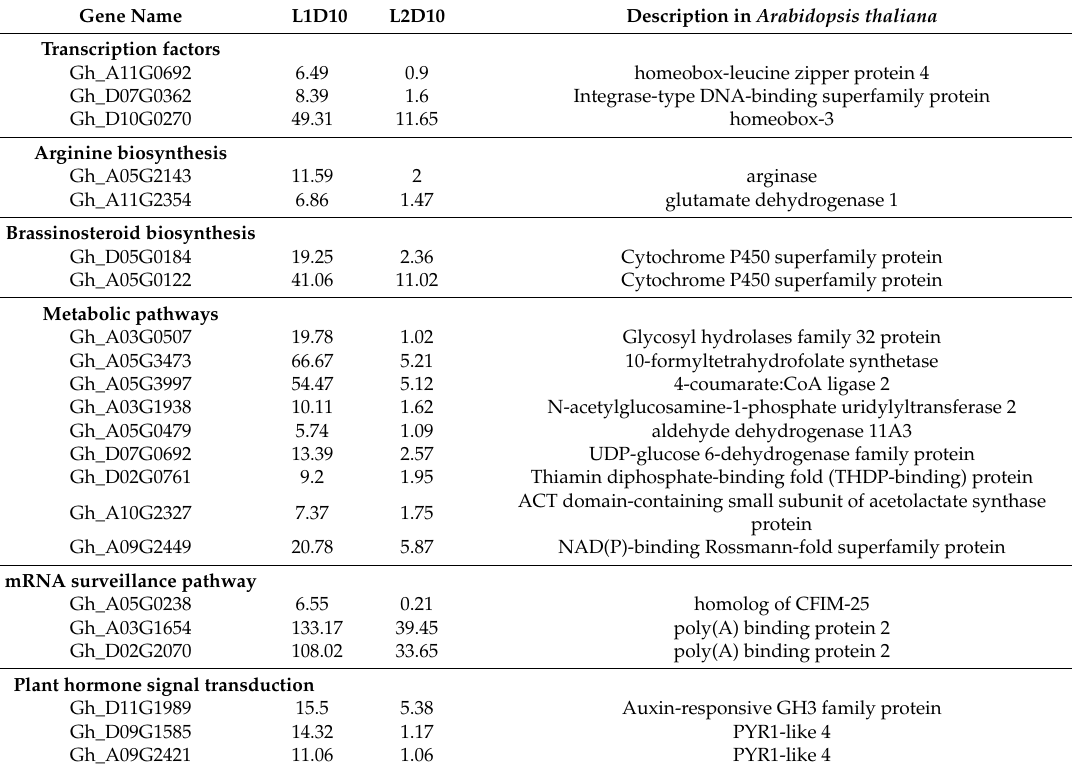
Table 1. Fragments per kilobase of exon per million reads (FPKMs) and functional categories of genes significantly up-regulated in L1 on 10DPA.